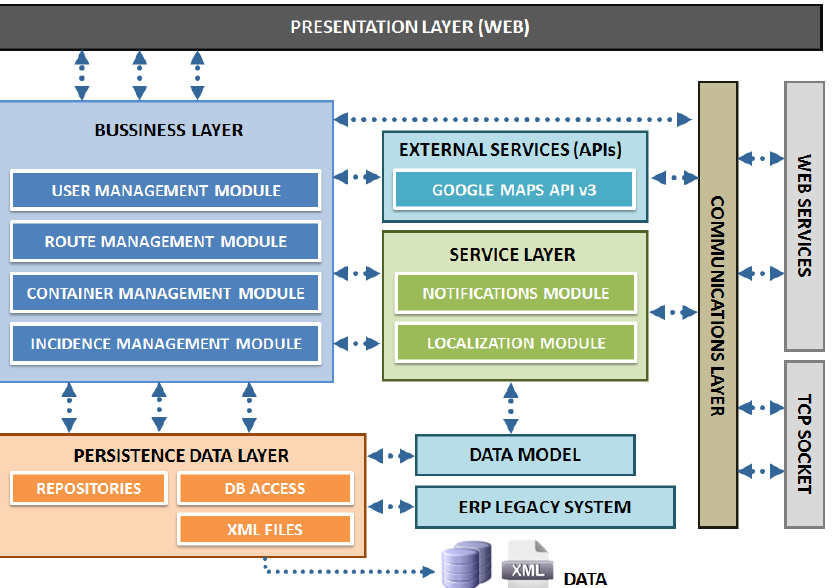
Figure 12. Architecture of the control software